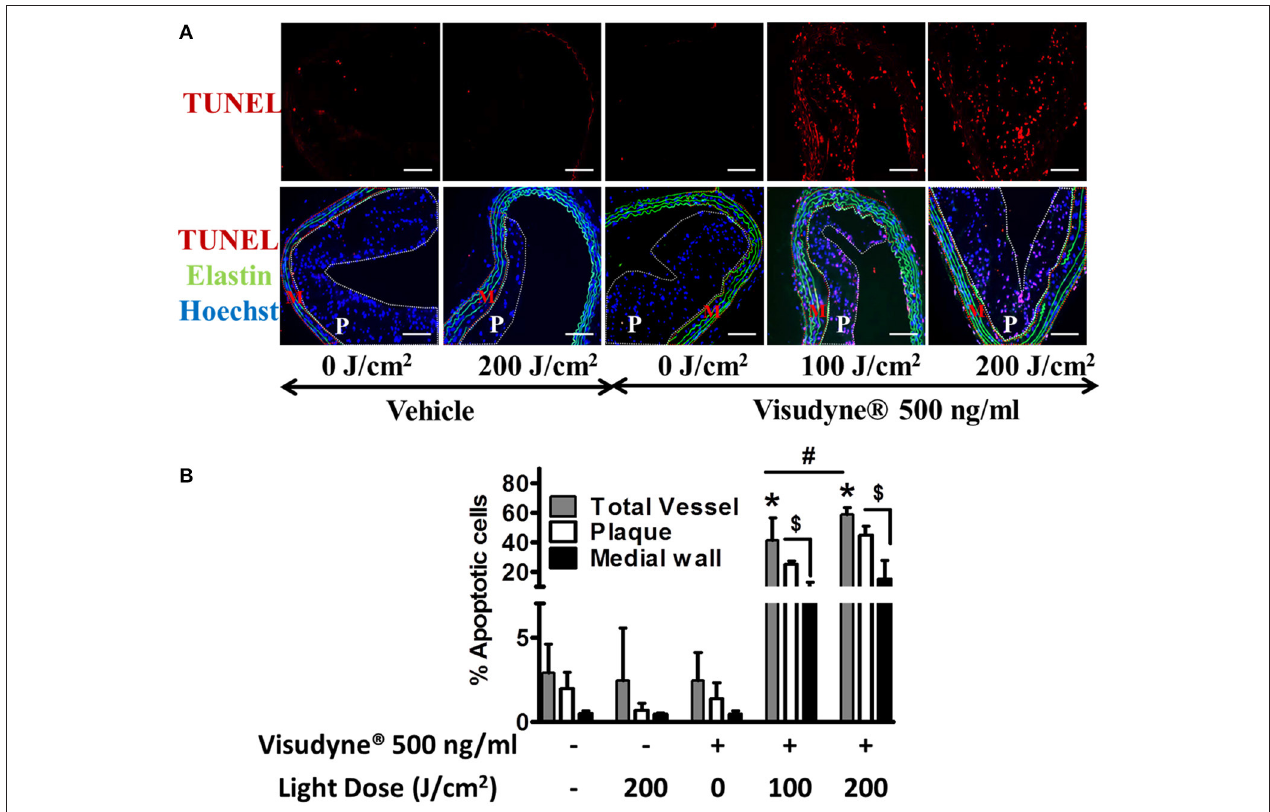
FIGURE 6 | Visudyne ® -PDT induced apoptosis of plaque cells. (A) TUNEL assay was performed after 24h in arteries treated with vehicle ( n = 5), laser only ( n = 4), Visudyne ® only ( n = 6), Visudyne ® treated, laser (100J/cm 2 ; n = 5), or Visudyne ® treated, laser (200J/cm 2 ; n = 4) treated groups. Upper panel shows TUNEL positive cells and are indicated by red fluorescence and lower panel is merged images with Hoechst (blue) and elastin (green) auto fluorescence. The plaque area is encircled with white dotted line and marked as P, while the media beneath plaque is marked as M and encircled by red dotted line. Scale bar: 100 µ m. (B) Bar diagram representing the percentage of TUNEL-positive cells in total vessel, plaque or in media beneath plaque. * P < 0.05 vs. vehicle treated groups, # p < 0.01 100 vs. 200J/cm 2 , $ p < 0.001 plaque vs. media beneath